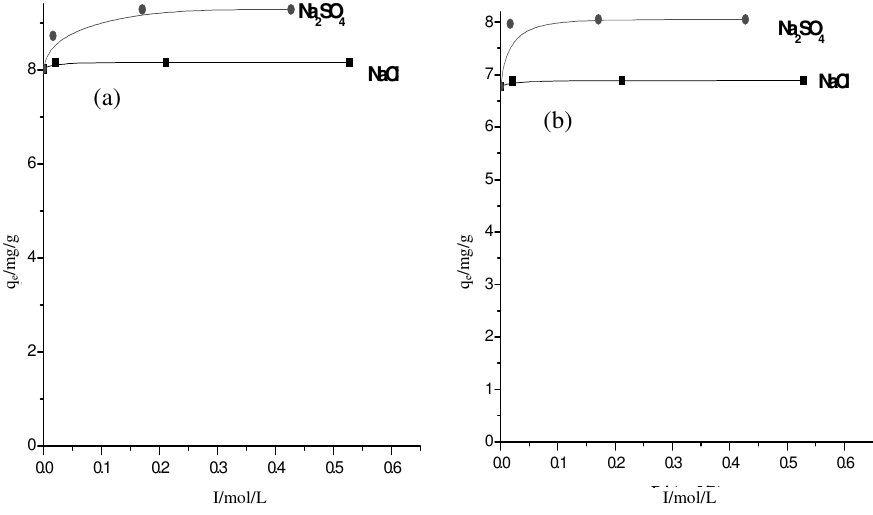
Figure 3. Influence of ionic strength on adsorption capacity of EG for PVA, (a) PVA 500; (b) PVA